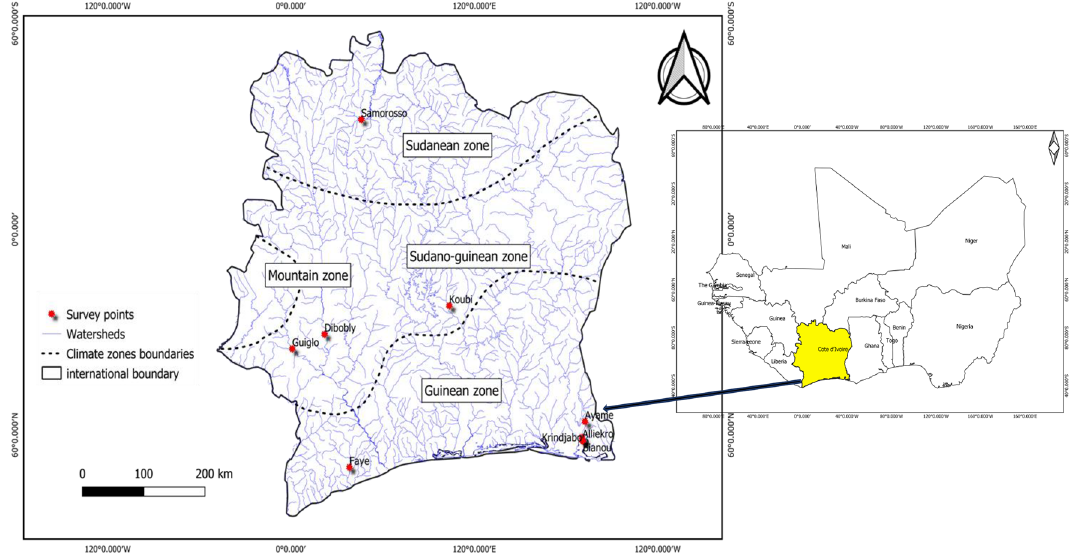
Fig. 1 The study area map, showing the borders of Côte d’Ivoire, its position in West Africa, the main climate zones and the locations where surveys were